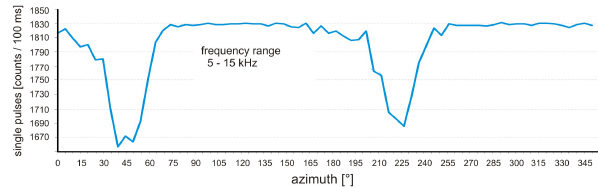
Fig. 8. Results of a horizontal measurement recorded close to Frankfurt am Main (Germany) with a higher amplification (117dB), a discrimination of 24 and a band-pass filter between 5 and 15kHz on 19 December 2011 during the annual intermission of DHO38. The plateau at 1830 single pulses per 100ms and the direction of the minimum intensities point to the French VLF transmitter HWU broadcasting at 18.3kHz.